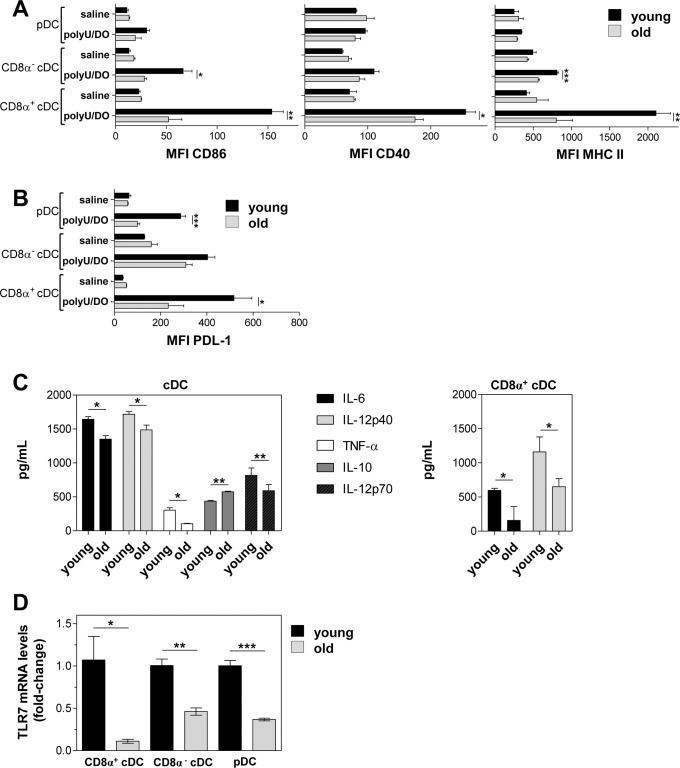
DC maturation is affected by aging.(A and B) Young and old mice were intravenously injected with 100 μg polyU/DO. Eighteen hours later, expression levels of CD86, CD40, MHC II (A) and PDL-1 (B) were determined in DC subsets by flow cytometry. Total (C) or CD8α+ (D) cDCs purified from the spleen of young and old mice were stimulated with 20 μg/mL polyU/DO and then supernatants were assayed for cytokine production by ELISA. (D) Spleen DC subsets from young and old mice were purified and total RNA of 1x106 DCs was extracted. Relative mRNA levels for Tlr7 were quantified by qPCR and normalized to Hprt1. Data show the mean ± SEM. Results are representative of 3 independent experiments (3–4 mice/age group/experiment). *p < 0.05, **p < 0.01, ***p < 0.001.